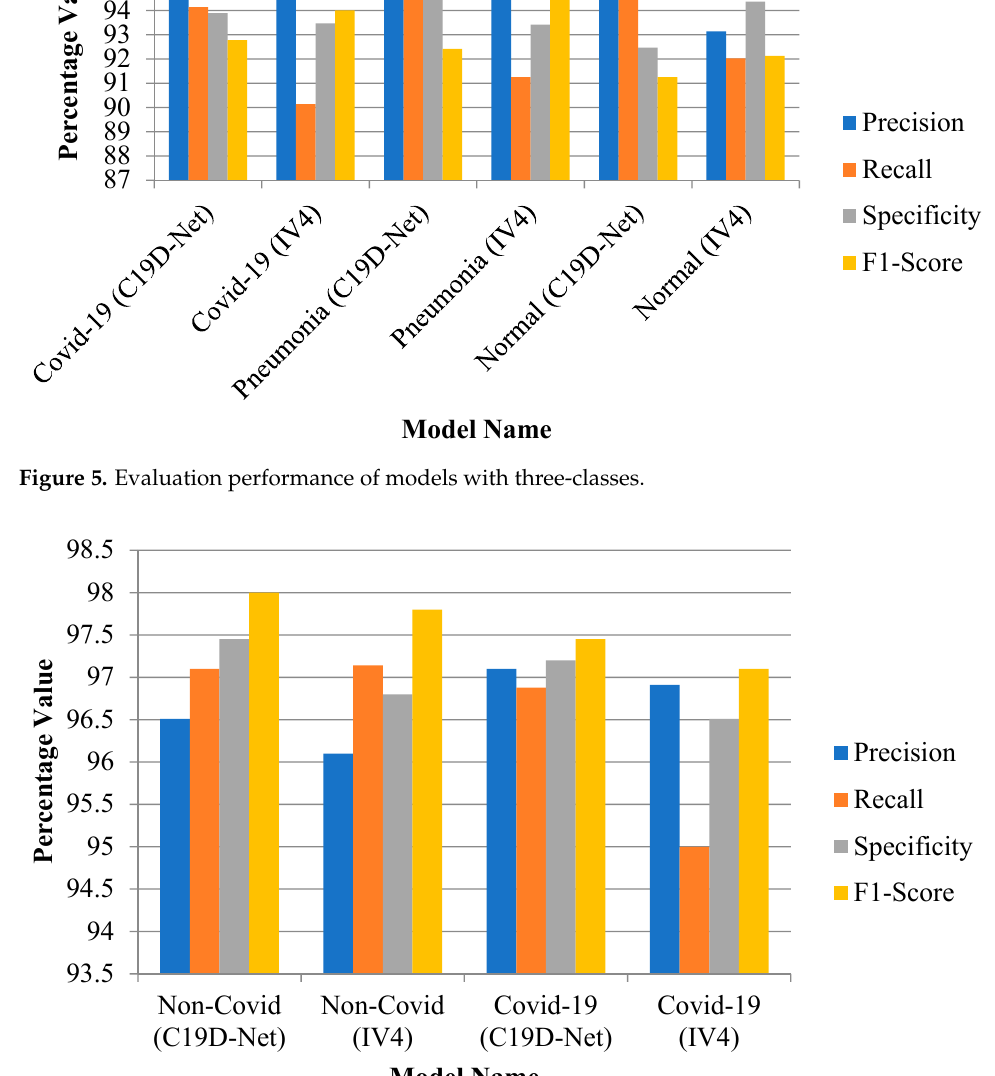
Figure 6. Evaluation performance of models with two-classes.